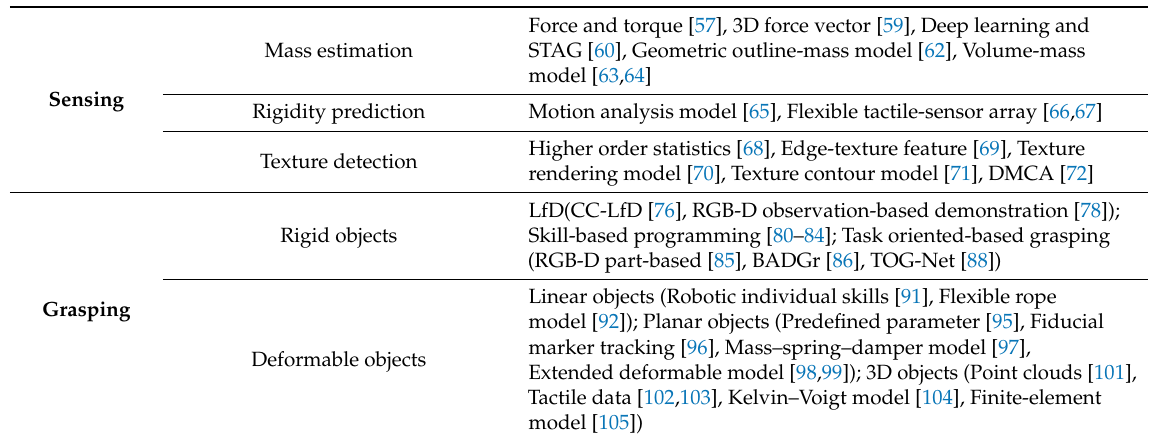
Table 2. Feature sensing and robotic grasping for physical-uncertain objects.